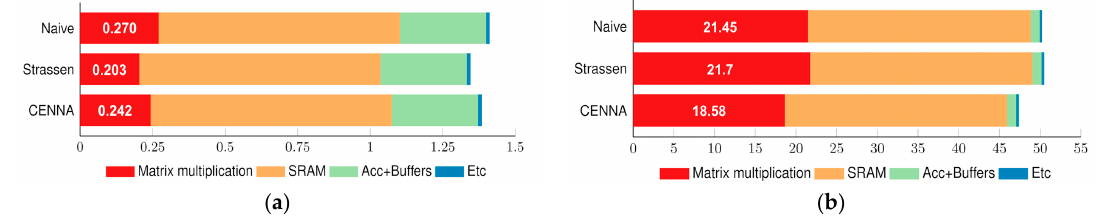
Figure 11. Comparison of methods: ( a ) silicon area (mm 2 ); ( b ) power consumption (mW).